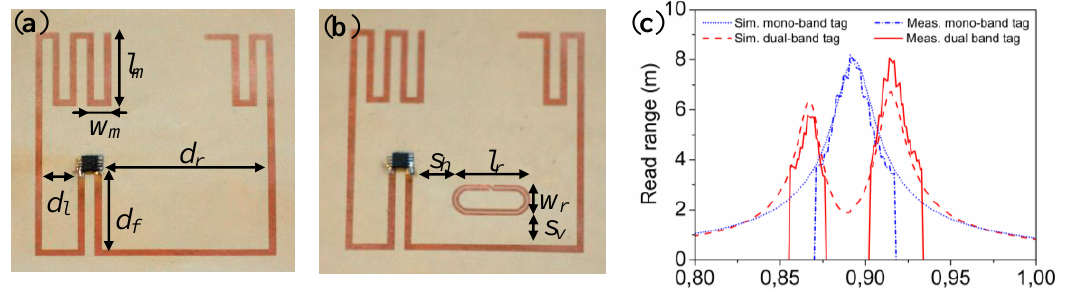
Figure 21. Photographs of the mono-band ( a ) and dual-band ( b ) fabricated UHF-RFID tags. ( c ) Measured and simulated read ranges. The dimensions of the tag are 48 mm  48 mm, and the strip width is 1.4 mm. The other relevant dimensions are l = 16.3 mm, w = 4.8 mm, d = 7.3 mm, d = 33.9 mm and d = 14.2 mm. The m m l r f